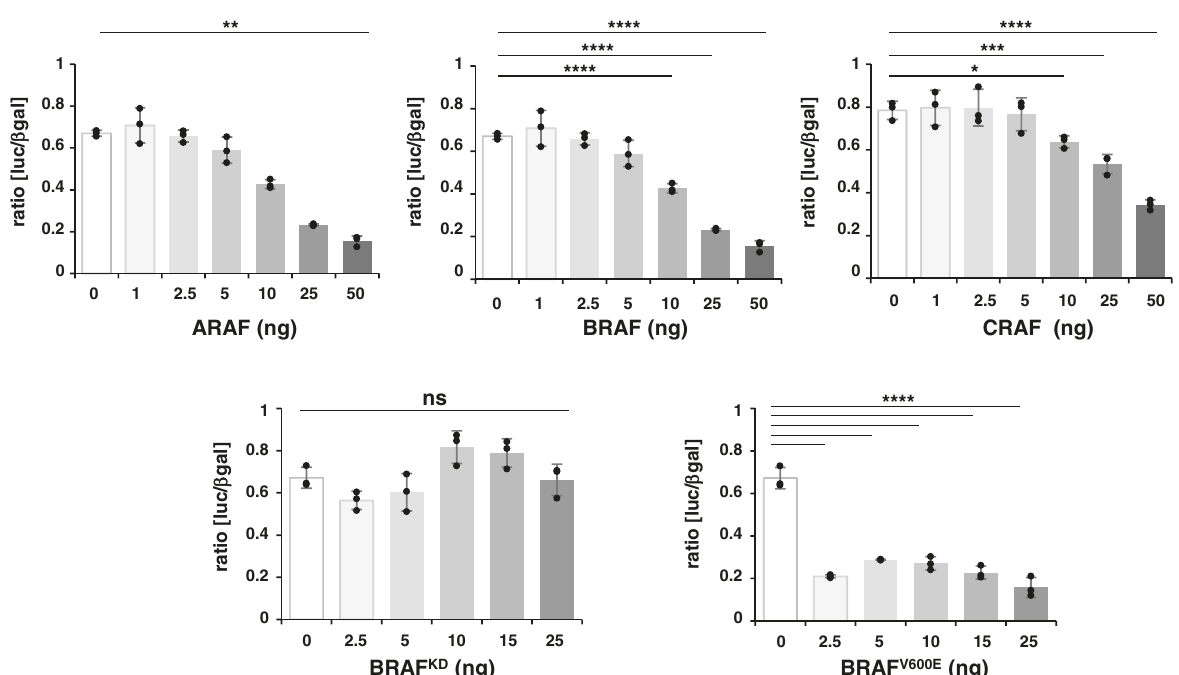
Fig. 6 Effect of RAF proteins on MITF transcriptional activity. HEK293T cells were cotransfected with 5 ng of MITF plasmid and increasing doses of either ARAF, CRAF, BRAF WT , BRAF V600E or BRAF KD constructs in the presence of a TYR-Luc luciferase reporter and a control β -galactosidase reporter. The ratio of luciferase to β -galactosidase activities is shown as the mean with standard deviations of three replicates ( n = 3). One-way ANOVA test was performed to compare all conditions and Dunnett ’ s tests for the multiple comparisons to the no MITF condition (n.s., non-signi fi cant; * p value <